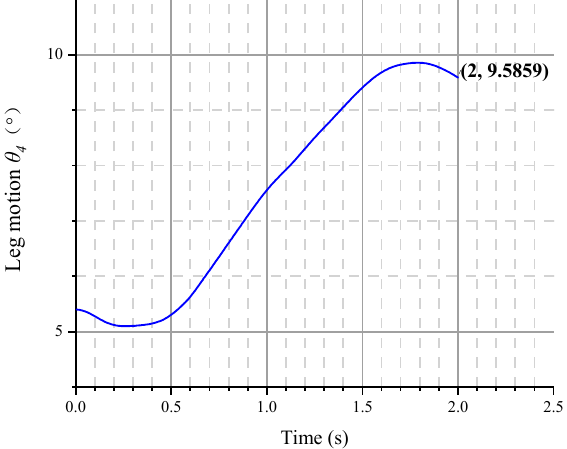
Figure 18. Change process of 6-DOF model legs posture angle.